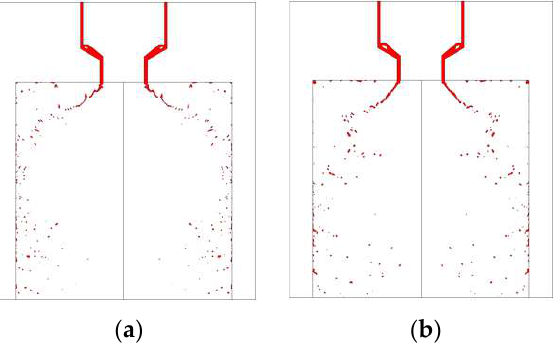
Figure 12. Comparison of NTO spray development at 5 ms under different valve strokes: ( a ) 0.15 mm, ( b ) 0.25 mm, at 1 m/s switch speed with downstream orifice plate.